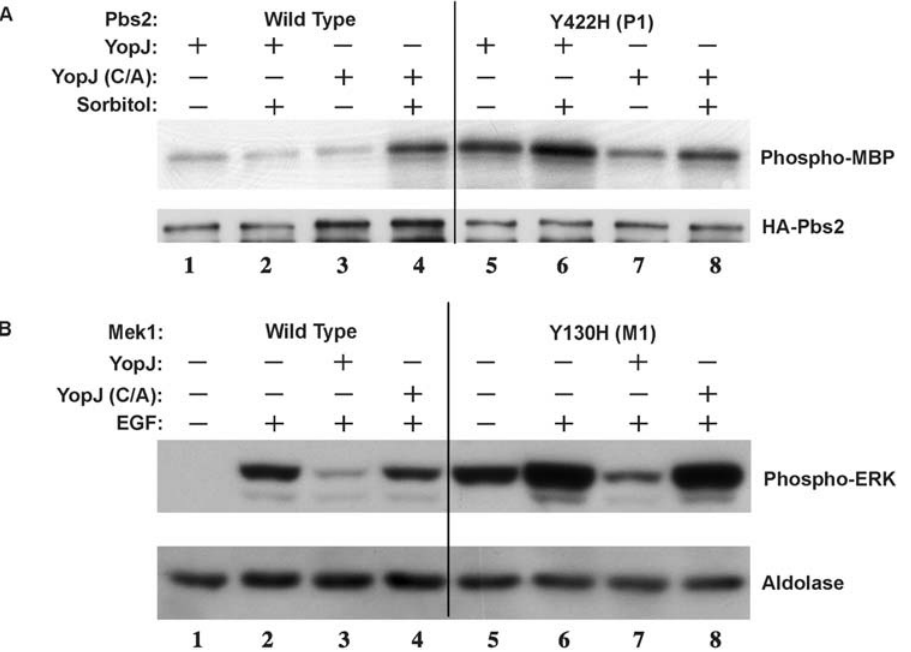
Figure 5. P1 mutant exhibits a higher basal kinase activity. (A) Pbs2 wild type or P1 mutants expressed in yeast pbs2 D strain with or without sorbitol stimulation are purified and incubated with MBP and 32 P- c -ATP at 30 u C for 30 minutes. The samples are separated by SDS-PAGE, transferred to PVDF membrane and then analyzed by autoradiography. The same membrane is probed with an anti-HA antibody. (B) HEK293 cells are transfected with either Flag-tagged YopJ or YopJ(C172A), HA-tagged ERK and HA-tagged MKK1 wild type or M1 mutant. Cells are lysed and immunoprecipitated using an anti-HA antibody and Protein G beads. Beads are separated using SDS-PAGE and probed with either anti-HA or anti-phospho ERK antibodies.